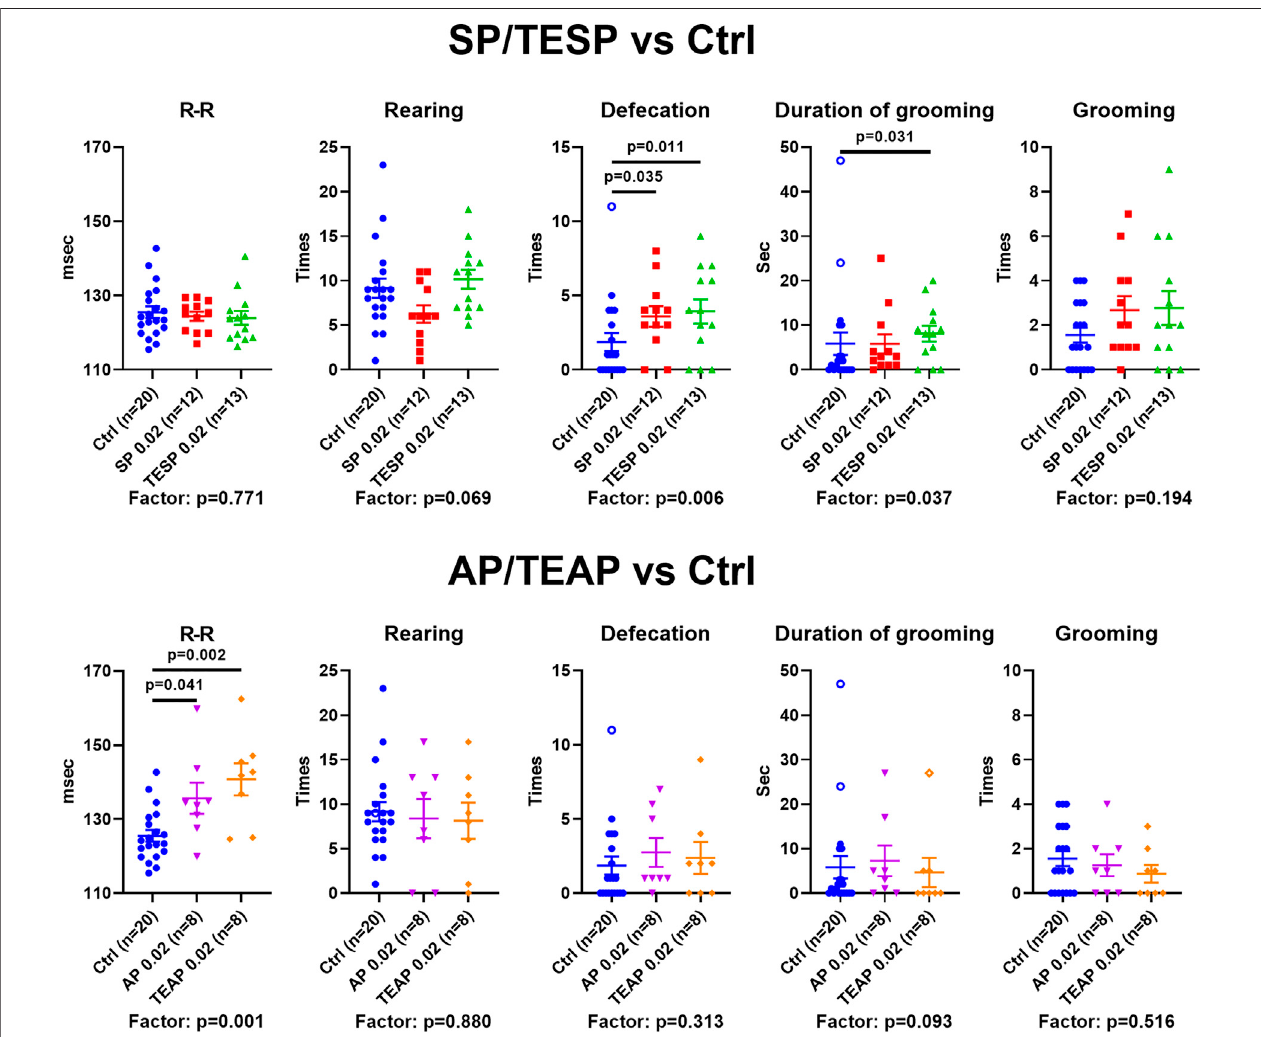
FIGURE 3 | Speci fi c physiological effects of administration of succinyl phosphonate (SP), adipoyl phosphonate (AP), and their triethyl esters (TESP and TEAP) to animals. All inhibitors are administered at 0.02 mmol/kg. R – R interval of ECG, number of rearing acts, number of defecation acts, duration of grooming, and number of groomingactsareshowninthecontrol(Ctrl)animalsandthosetreatedwithSP/TESP(upperpart)orAP/TEAP(lowerpart).Signi fi cant( p ≤ 0.05)differencesbetweenthe experimental groups, estimated by ANOVA with Tukey ’ s post hoc test, are indicated on the graphs. The ANOVA p -values for the treatment factor signi fi cance are shown below the graphs. The hollow points correspond to outliers excluded from statistical analysis according to the iterative Grubb ’ s test. The number of animals in experimental groups ( n ) is indicated including outliers.